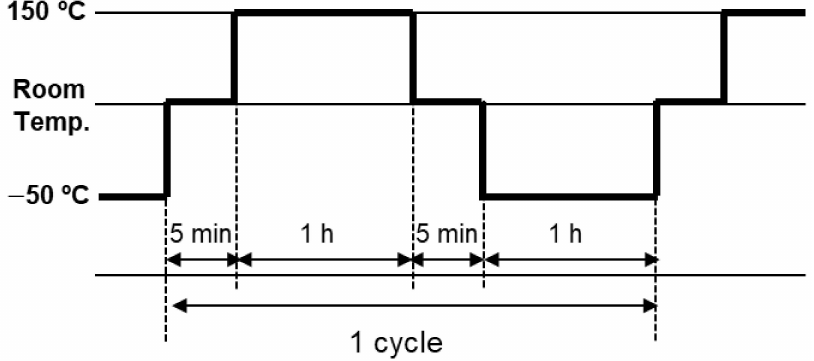
Figure 2. Thermal shock test